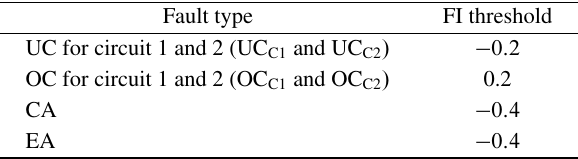
Table 4 List of faults with FI threshold.